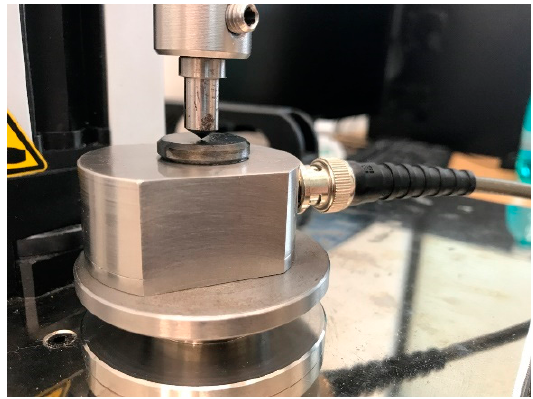
Figure 4. Specimen indentation with special AE sensor DAKEL type Holder.